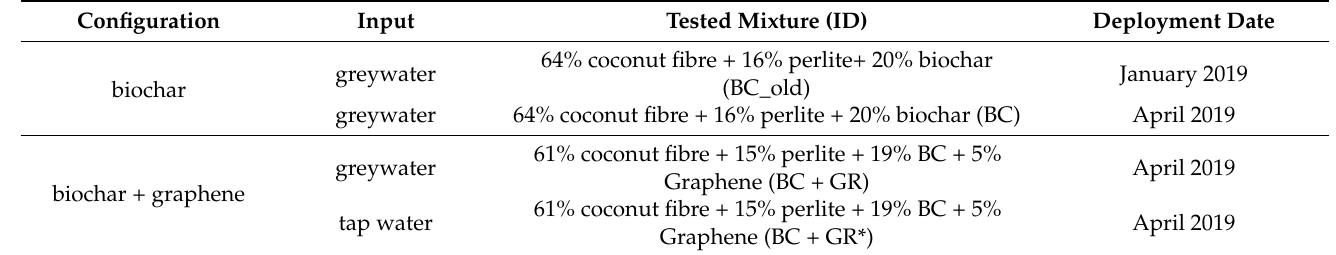
Table 2. Composition of the synthetic greywater (GW) used in this study.